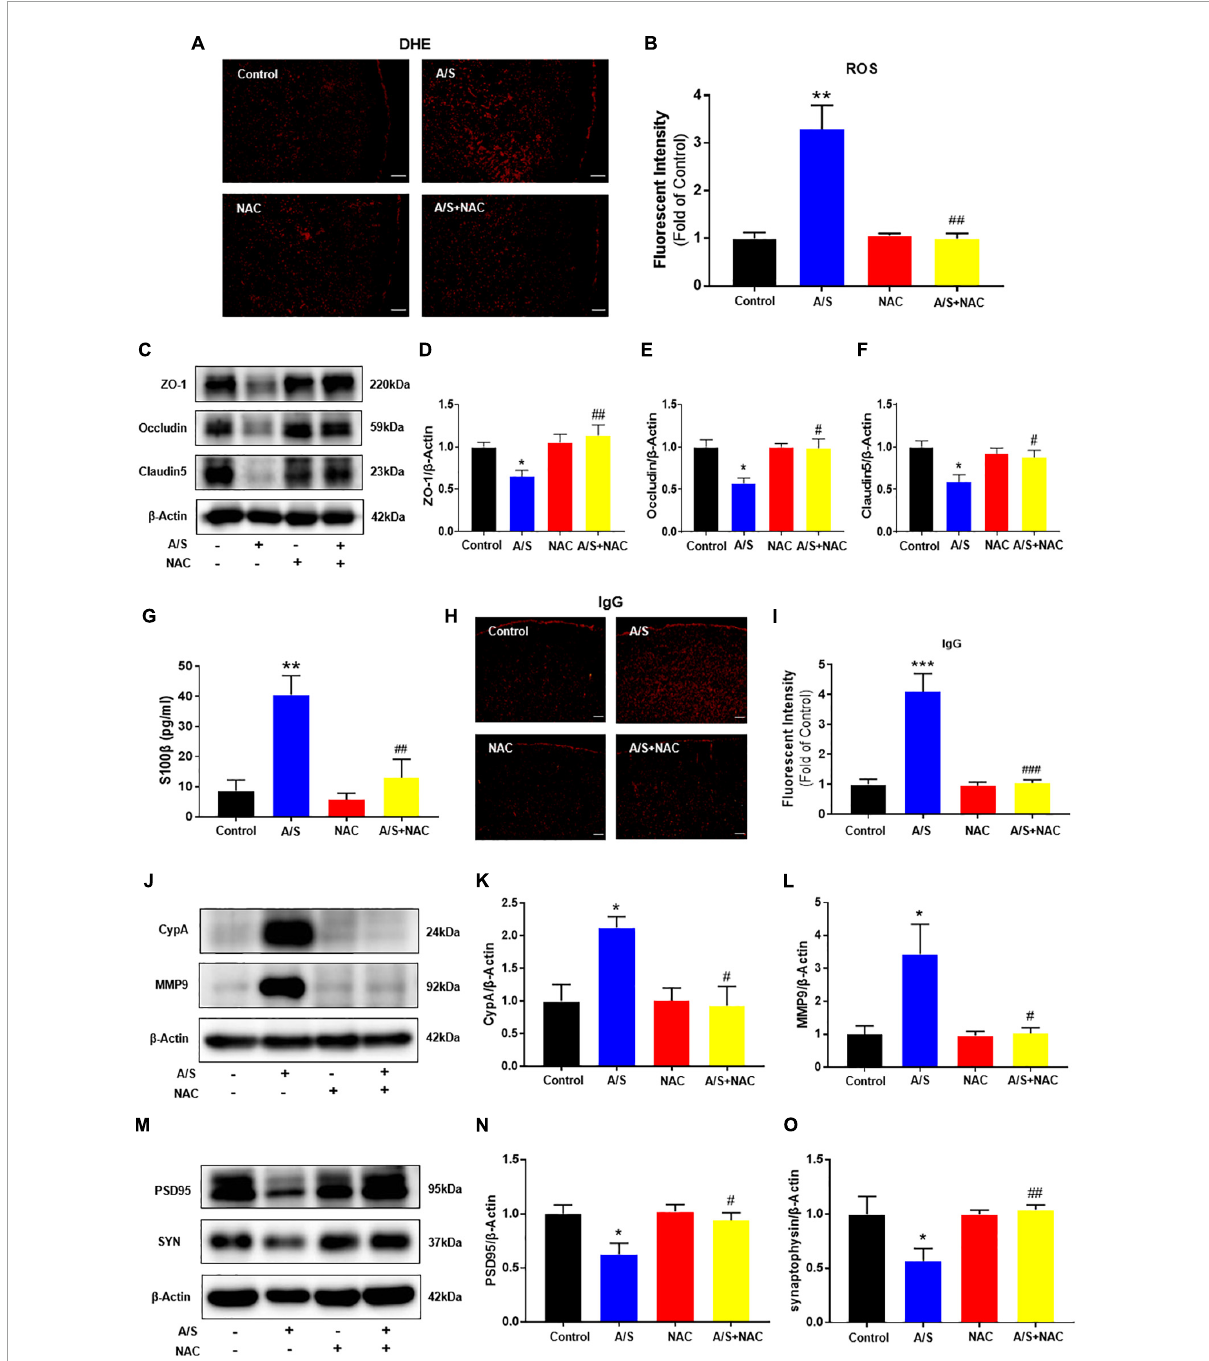
FIGURE2 Effects of ROS on the CypA/MMP9 pathway, BBB permeability, and synaptic plasticity proteins in anesthesia/surgery mice. Scavenging of ROS improves the tight junction (TJ) proteins, attenuates the BBB leakage, and CypA/MMP9 activation, as well as increases synaptic plasticity proteins in anesthesia/surgery mice. The level of reactive oxygen species (ROS) in the prefrontal cortex was assessed by DHE staining (A,B) . Scale bars: 100 µ m. The protein levels of CypA, MMP9 (J–L) , ZO-1, occludin, claudin5 (C–F) , PSD95, and synaptophysin (M–O) were assessed by western blotting. S100 β levels in serum were measured by ELISA (G) . IgG leakage staining (red fluorescence) was shown in the cortex (H,I) . Scale bars: 100 µ m. Values are expressed as mean ± SEM and were analyzed by one-way analysis of variance, followed by Tukey’s post-hoc test. n = 3–5 per group. A/S, anesthesia/surgery. * P < 0.05, ** P < 0.01, *** P < 0.001, compared to control group; # P < 0.05, ## P < 0.01, ### P < 0.001, compared to A/S